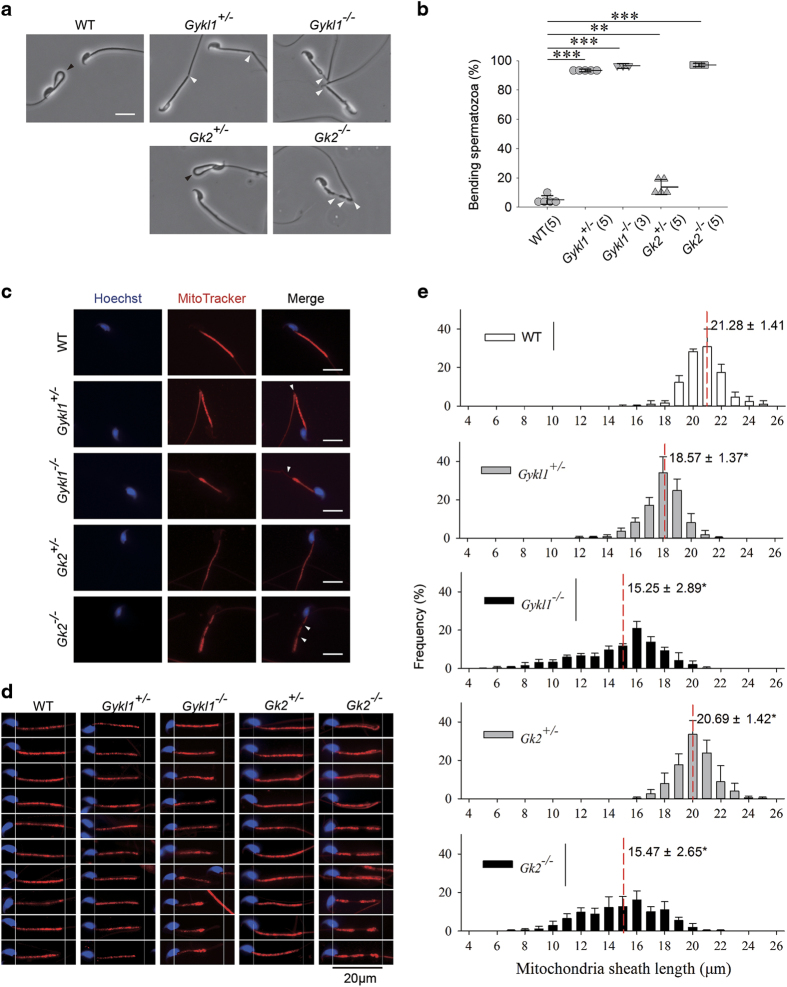
The spermatozoa from male Gykl1 and Gk2 KO mice display mitochondrial defects. (a) The spermatozoa from the epididymis of wild-type and mutant mice were visualized under the microscope. Black arrows indicate normal bending of sperms which is smooth. White arrows indicate abnormal gaps between the mitochondrial sheath and tail. (b) The spermatozoa from (a) were scored and plotted to calculate the mean percentage of spermatozoa with bending (e.g., hairpins or gaps). Error bars indicate s.d. Numbers in parentheses indicate sample size (n). Significance was determined by the ANOVA. **P<0.01. ***P<0.001. (c) The spermatozoa from various mice were stained with MitoTracker dye to visualize the mitochondria and Hoechst 33342 was used to visualize the nuclei. White arrows indicate gaps between the mitochondrial sheath and tail. Scale bar: 10 μm. (d and e) The spermatozoa from various mice were collected to measure the length of mitochondrial sheath. Some representative spermatids measured in e are shown in d. The distribution of the measurements is plotted in e. The red line indicates average length. Error bars represent s.d. More than 300 spermatozoa were collected from 3–5 animals of each group. Significance was determined by the ANOVA. *P<0.05, compared with WT.